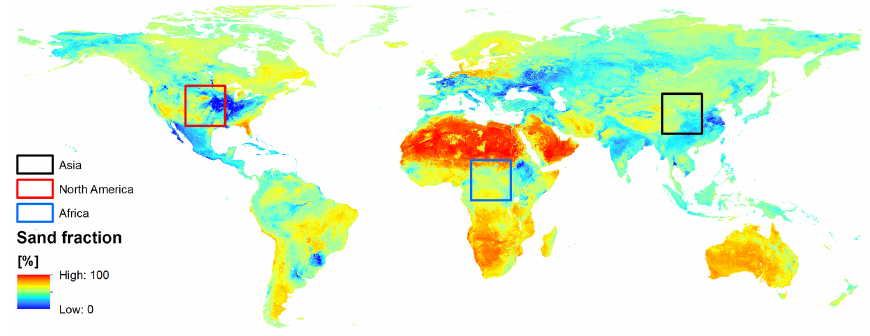
Figure 4. Example regions selected to evaluate the scaling variance loss from Warrick scaling at different spatial resolutions when neglecting the scaling variance. The background shows the sand fraction from